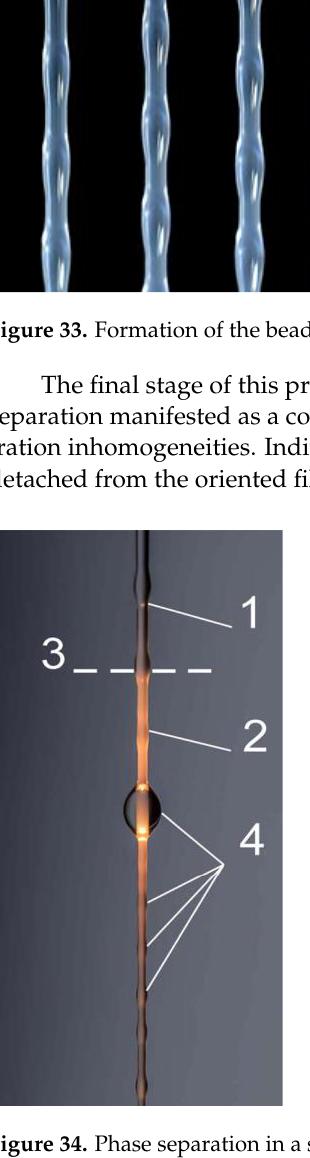
Figure 34. Phase separation in a stretched solution jet. 1—fluid part; 2—solidified part; 3—boundary of the phase separation detected due to appearance of light scattering on concentration fluctuations; 4—large and small solvent droplets spread over the filament